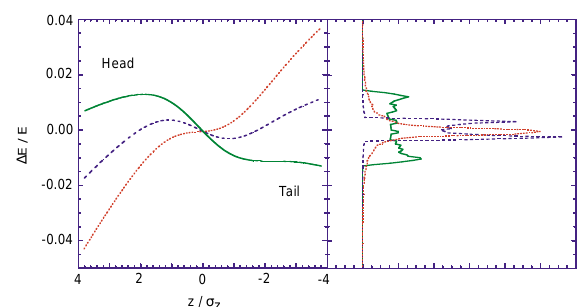
FIG. 4. (Color) Longitudinal phase space at the end of the NLC X-band linac when operating with an rf phase of 0 ± (solid), 10 ± (dashes), and 20 ± (dots) to partially compensate the longitudinal wakefield with the projections of the distributions on the energy axis to the